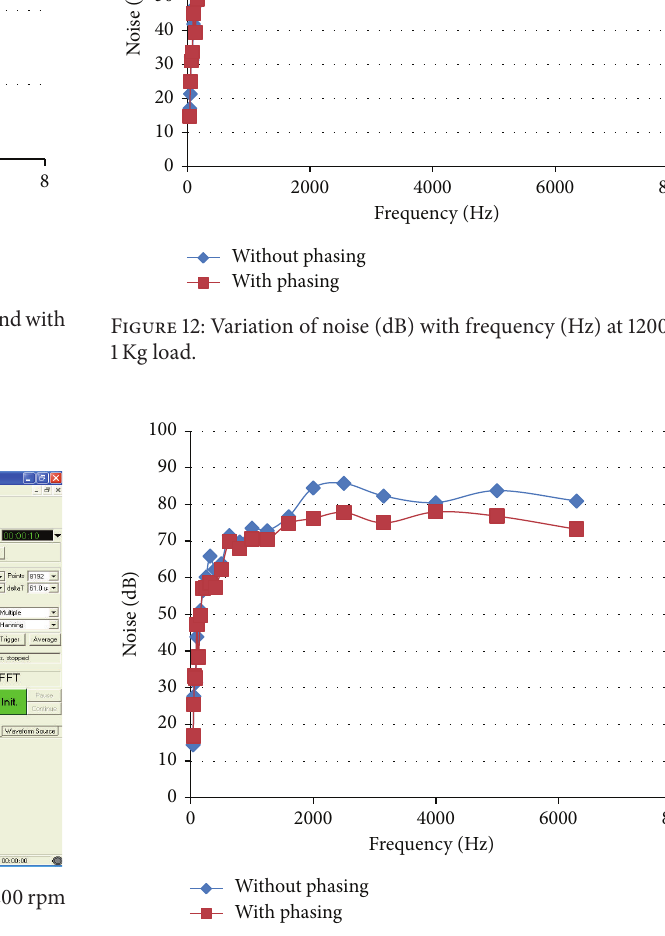
Figure 13: Variation of noise (dB) with frequency (Hz) at 1200rpm at 2kg